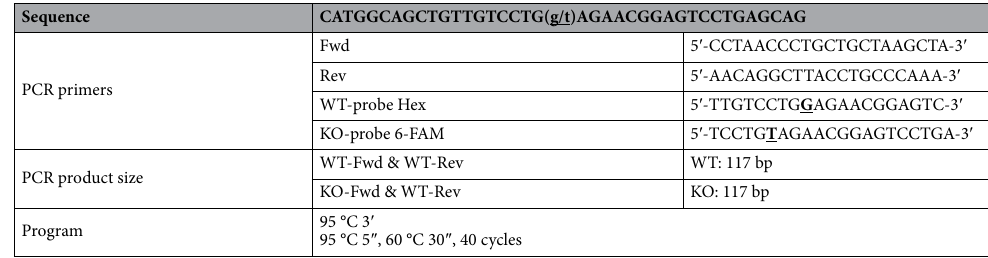
Table 1. The genotype of breeding animals was identified by genomic tail DNA probed with PCR applying indicated primer pairs and cycling conditions. Taqman qPCR protocol was run on a real time PCR instrument using an appropriate instrument specific Fluorophore/Quencher combination. The transgene genotype is determined by comparing ΔCt values of each unknown sample against known homozygous and heterozygous controls, using appropriate endogenous